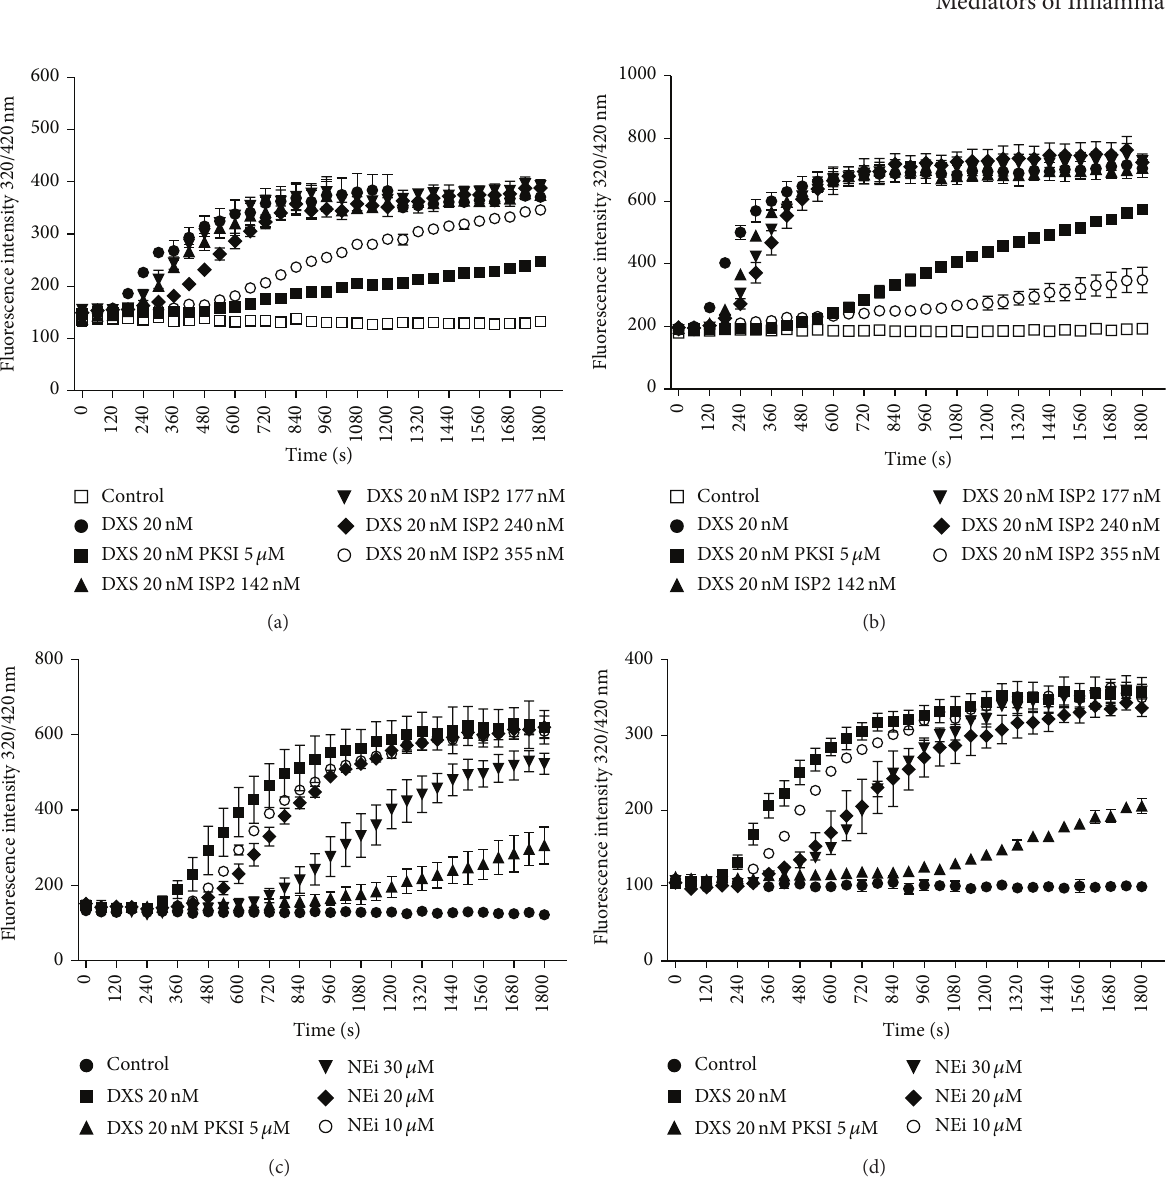
Figure4:EffectofISP2onDXS-inducedcontactphaseactivationofhumanplasma.Citratedhumanplateletfreeplasmadiluted1 :20inbuffer (described in methods) was supplemented with (i) 4 𝜇 M Abz-MTEMARRPQ-EDDnp (a, c) or 4 𝜇 M Abz-GFSPFRSVTVQ-EDDnp (b, d), intramolecular quenched fluorescent substrates whose sequences span the N-terminal or the C-terminal flanking sites (resp.) of BK in mHK (ii) dextran sulfate 500kDa (DXS; 20 nM). The substrate was also tested in the absence of DXS (Control). Assays with the elastase inhibitor (NEi—MeOSuc-AAPV-CMK-10, 20, and 30 𝜇 M), the synthetic PKa inhibitor (PKSI-527—5 𝜇 M), and the inhibitor of serine peptidase 2 (ISP2—142, 177, 240, and 355 nM) were performed using two different schemes. (a, b) PKSI or the elastase inhibitor was added to the plasma together with DXS and the substrate. (c, d) PKSI or ISP2 was preincubated with plasma for 15min, at 37 ∘ C, prior to the addition of DXS and = 320 nm and 𝜆 = 420 nm (up to 1800 seconds). The plot the substrate. Hydrolysis was followed by measuring the fluorescence at 𝜆 ex . em . shows the increase of fluorescence with time, reflecting substrate hydrolysis. The values in the figures represent the mean ± SE of duplicate determinations performed within 1 representative experiment of